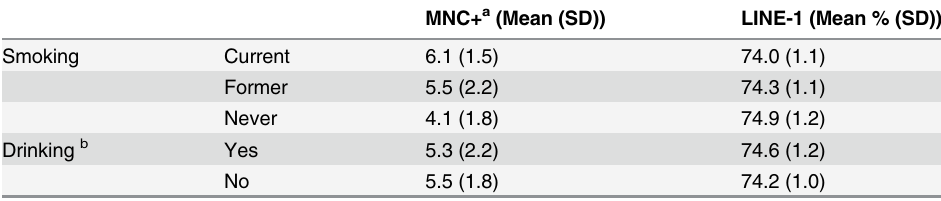
Table 2. Mean values of MNC+ and LINE-1 hypomethylation stratified by smoking and drinking